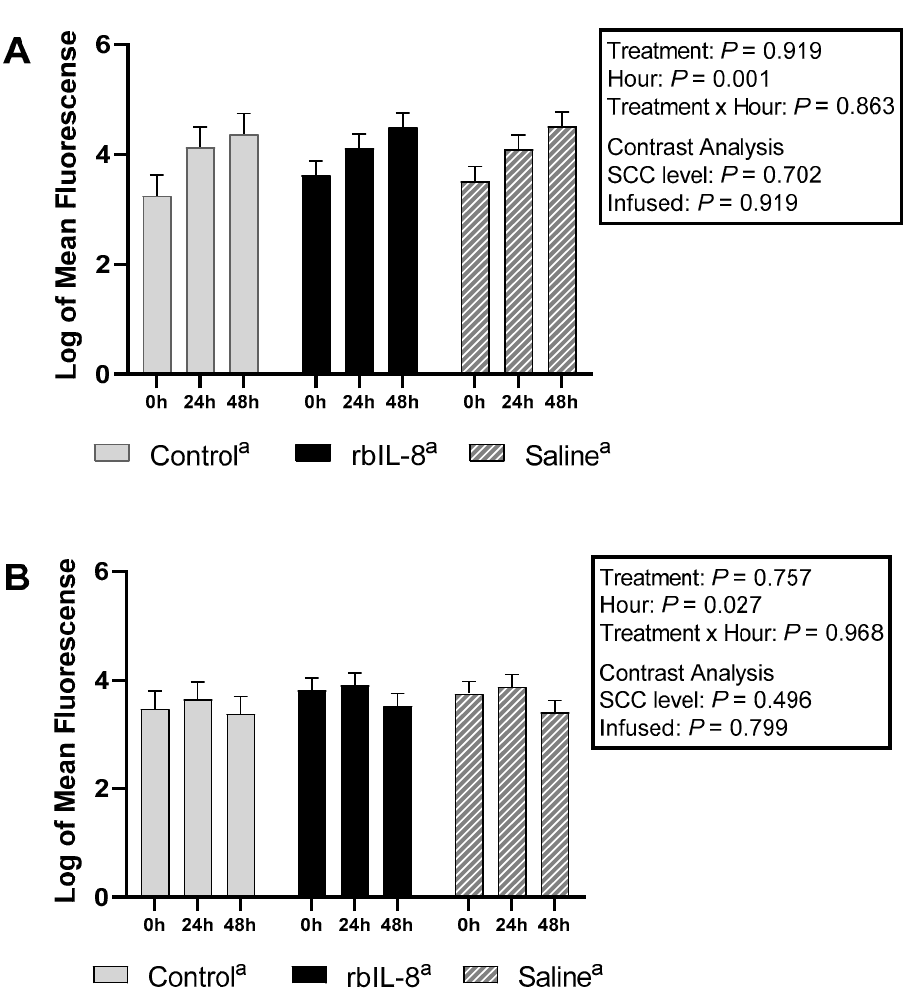
Figure 7. Mean fluorescence for neutrophils isolated from blood samples, for each respective dye, propidium iodide ( A ) and dihydrorhodamine ( B ), relative to hours post-treatment on flow cytometry. The treatment effect is a multiple comparison analysis among the groups. The SCC level was measured using a contrast comparing the chronic groups (rbIL-8 and saline) to the control, whereas the infused compared the rbIL-8 with the saline. Multiple comparisons were adjusted for Tukey–Kramer. Groups did not differ (superscripts a ) for the mean ± SE of log of neutrophils, in the multiple comparison analysis; p = ≤ 0.05 means a statistical significance, and 0.05 < p ≤ 0.10 means a statistical tendency.